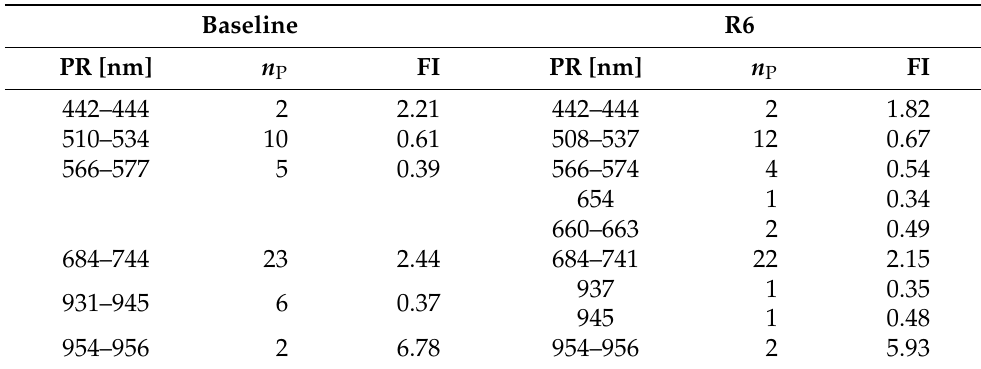
Table 3. Regions of continuous predictors with a minimum absolute feature importance of 0.32 (third quartile of the baseline variant) for the variants baseline and R6. Single predictors not connected to a continuous region were included. PR = predictor range [nm], n P = number of predictors, FI = feature